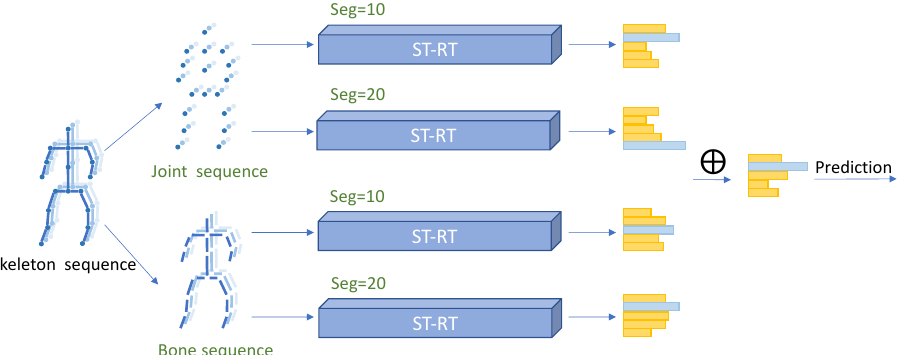
Figure 1. Illustration of the overall architecture of the proposed MSST-RT. The sum of all scores from four ST-RTs is treated as the final